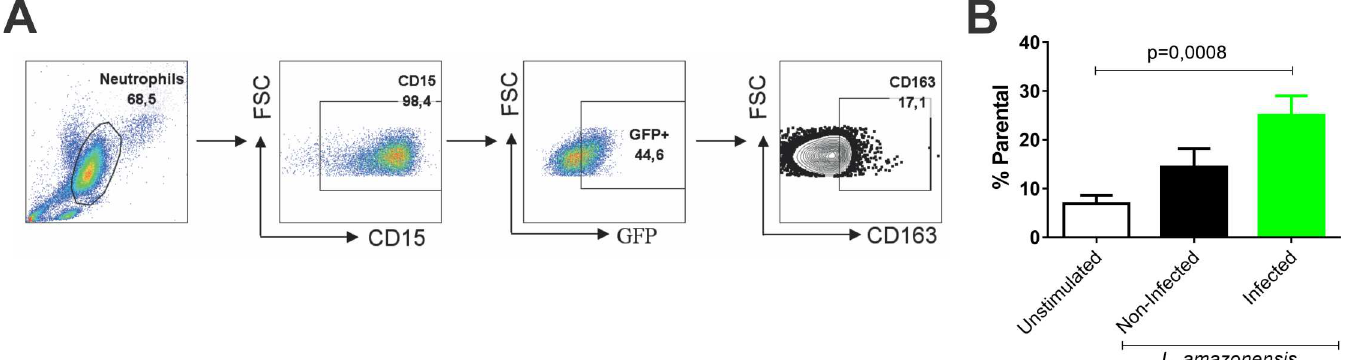
Fig 5. CD163 expression is induced by Leishmania infection of neutrophils. (A) Gating strategy for the analysisof neutrophilphenotypes. Neutrophils were purifiedfrom healthydonors and infected with GFP-expressing L . amazonensis (5 parasites: 1 neutrophil)in RPMI 1640 plus 10% FBS. (B) 3h after infection, neutrophilswere characterized by flow cytometry and data analyzedby FlowJo software (in duplicate, n = 5 experiments). Green and black bars represent,respectively,the GFP positive and negativecells. The white bars represent non-exposed group (unstimulated). The mean ± SD of parental percentage of GFP+, GFP- and non-exposed cells were comparedby Friedman pairedtest with Dunn’spost test.